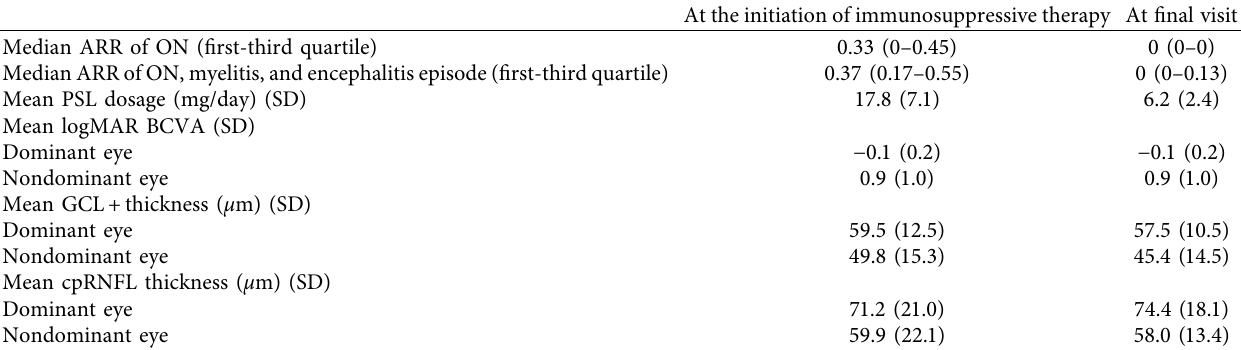
Table 3: The efficacy of immunosuppressive therapy. At the initiation of immunosuppressive therapy At final visit Median ARR of ON (first-third